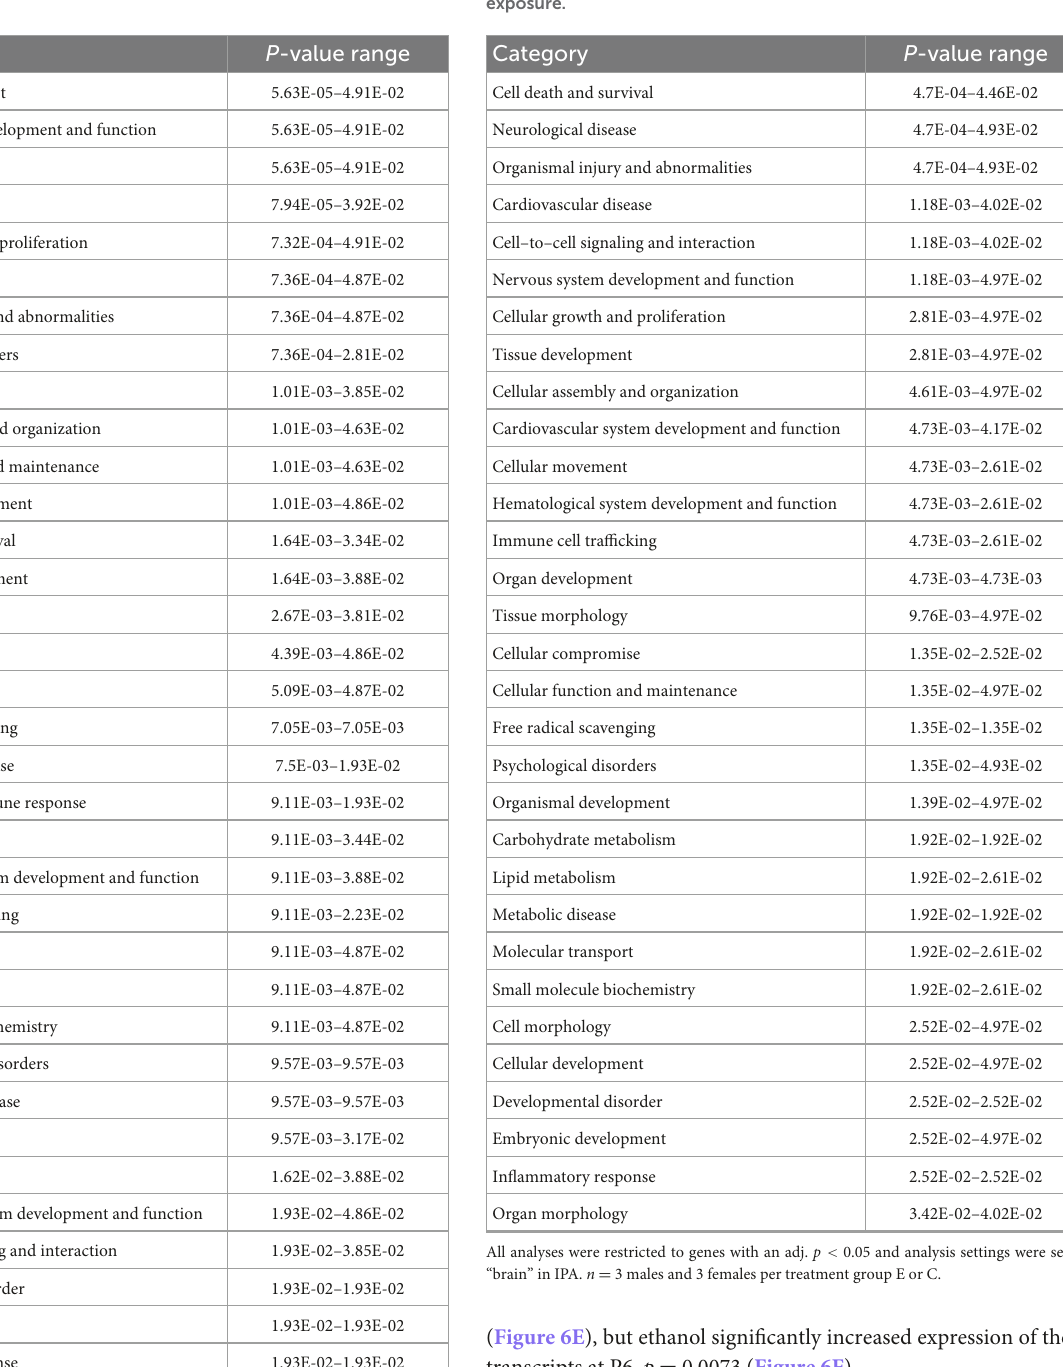
TABLE 1 P5-Top diseases and biological functions altered by ethanol exposure.